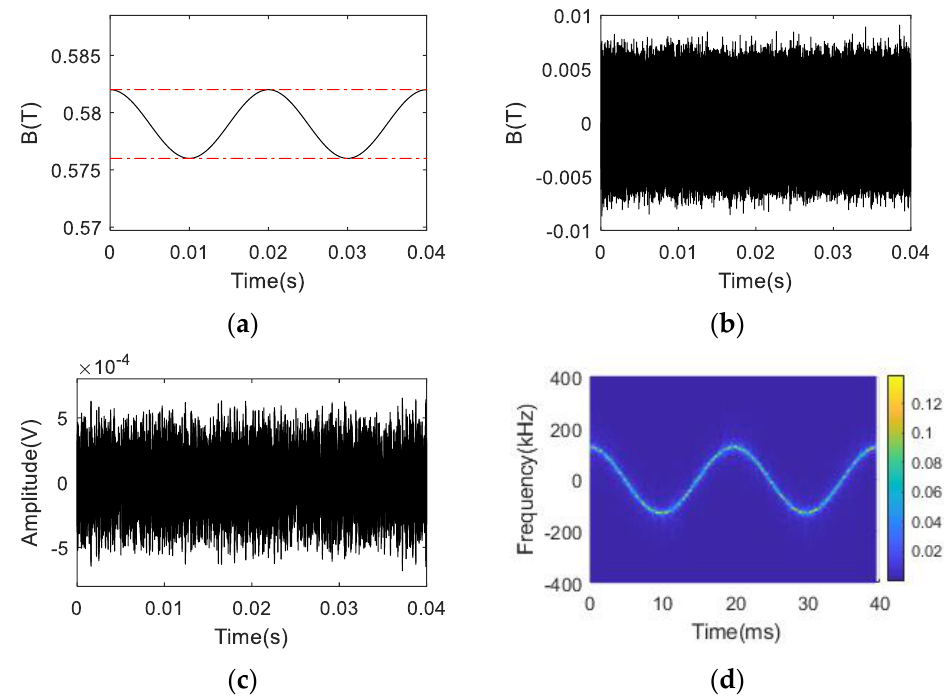
Figure 2. The numerical simulation results: ( a ) The waveform of the sinusoidal time − varying magnetic field; ( b ) The waveform of the RF excitation signal applied; ( c ) The waveform of the macroscopic magnetization component M y ( t ) ; ( d ) The STFT result of the macroscopic magnetization component M y ( t ) .